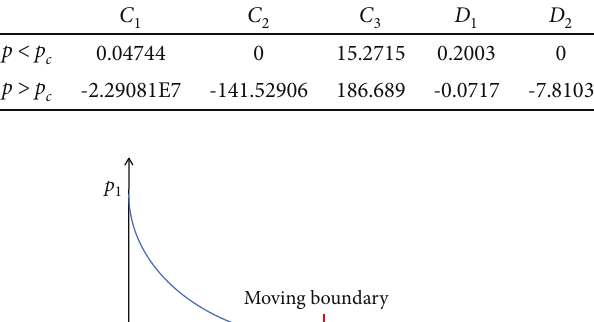
Table 2: Parameters for the fi tting formula of CO